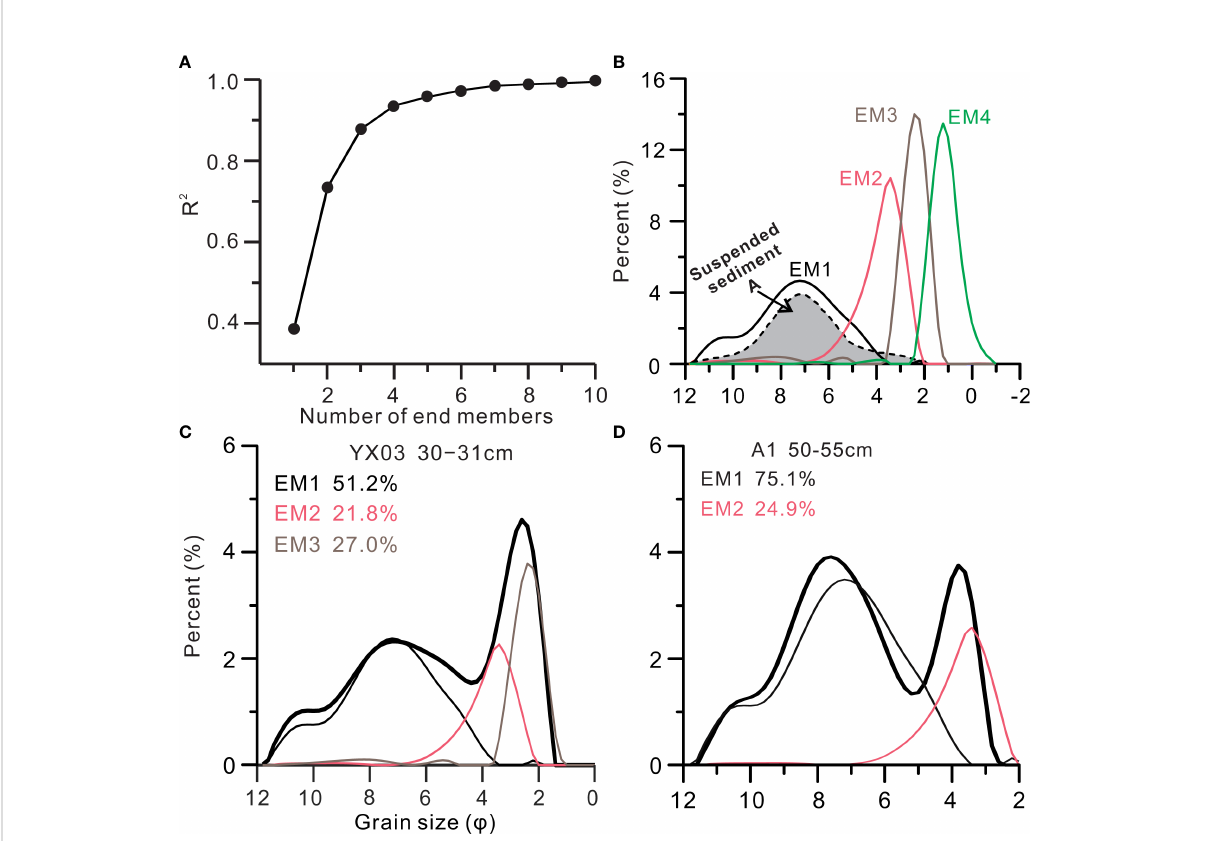
FIGURE 2 Correlation plots between the correlation coef fi cient (R2) and number of end-member (A) . (B) grain-size distribution of four end members. EM1 and suspended sediments from modern Pearl River (Zheng et al., 2017) have similar grain-size curves. (C, D) representive grain size distribution of samples from cores YX03 and A1 and the results of end-member